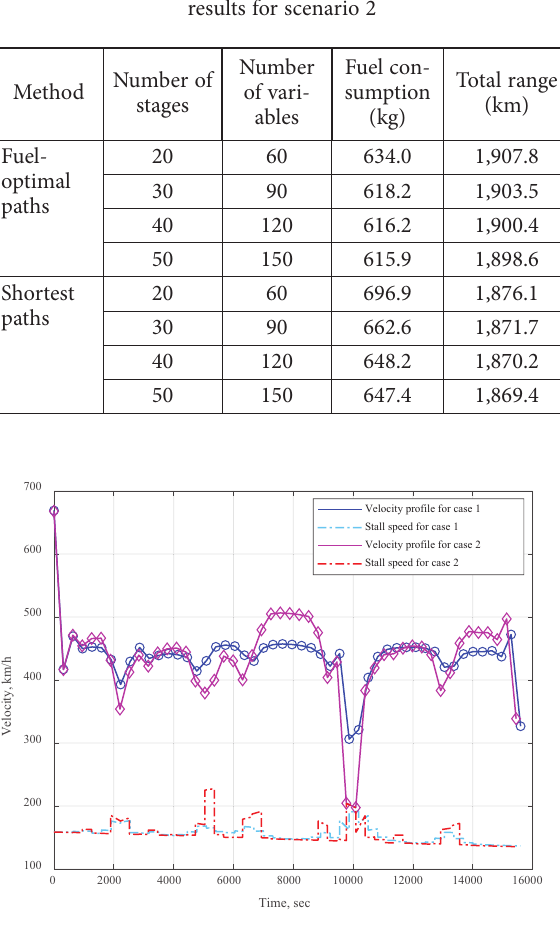
Table 4. Comparison of fuel and shortest-path optimization